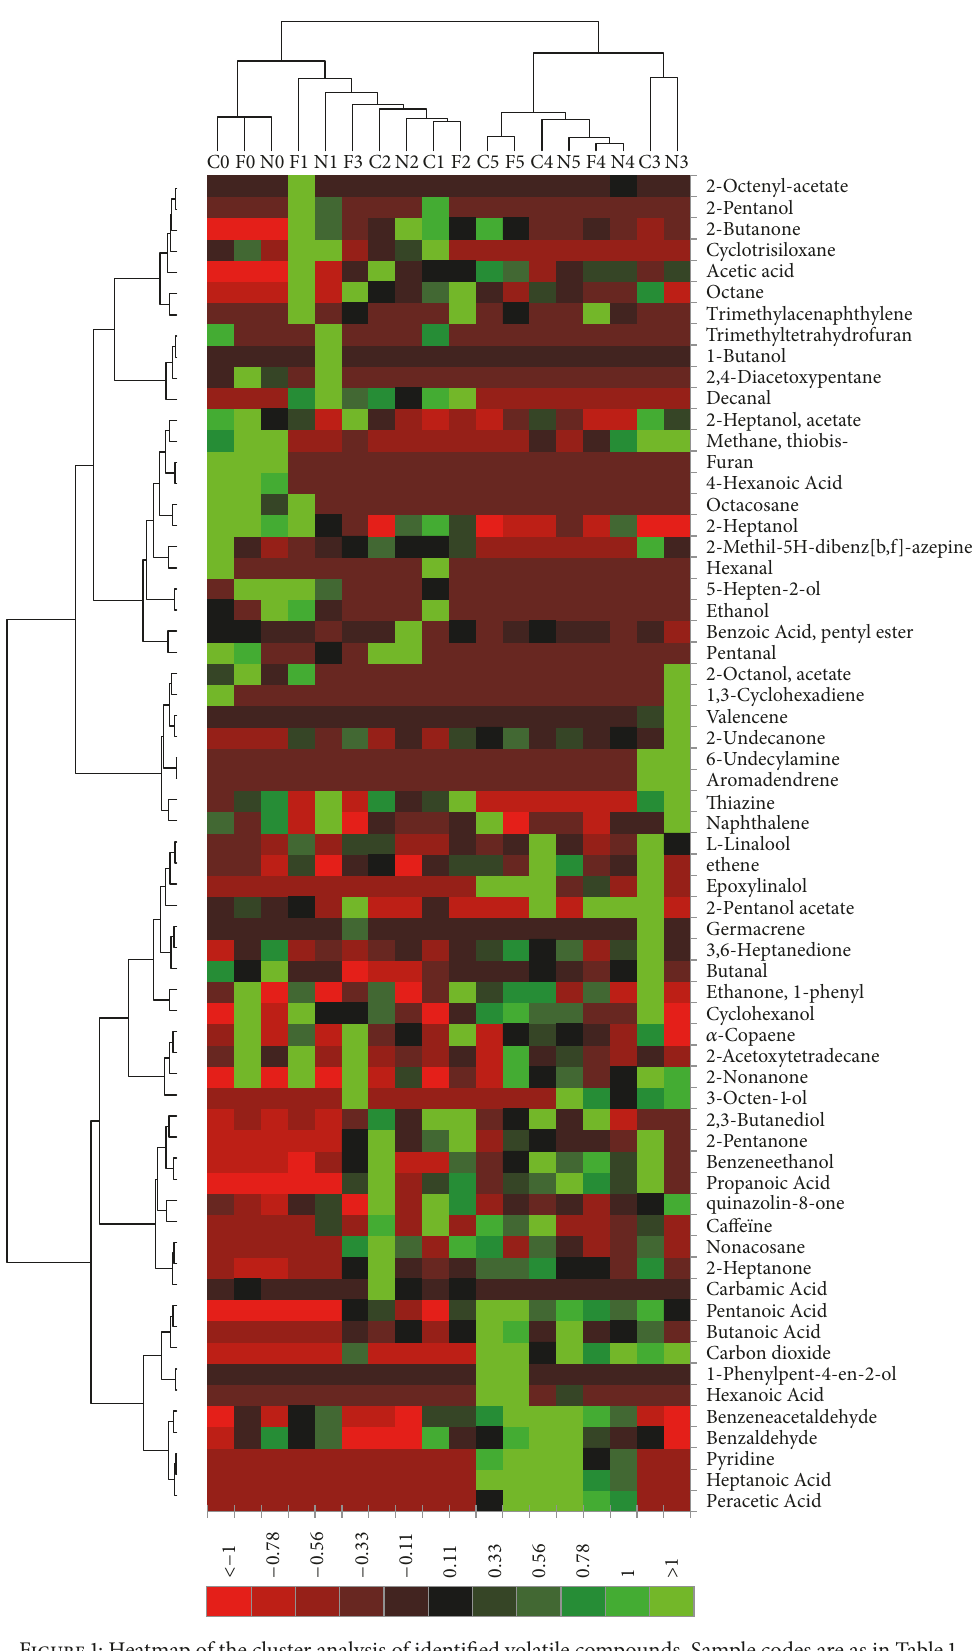
Figure 1: Heatmap of the cluster analysis of identified volatile compounds. Sample codes are as in Table